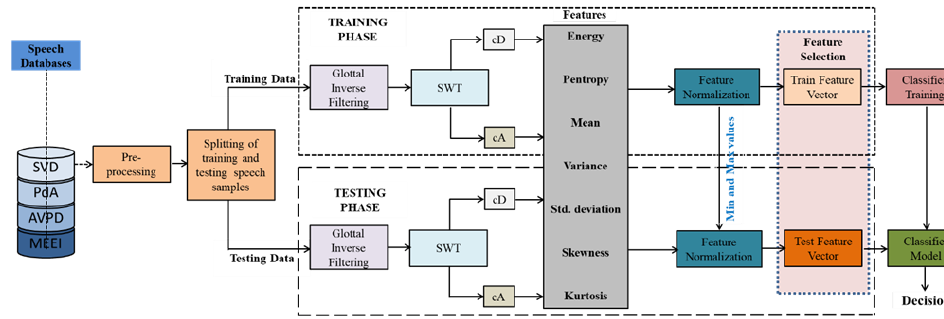
Figure 1. Voice disorder assessment system.